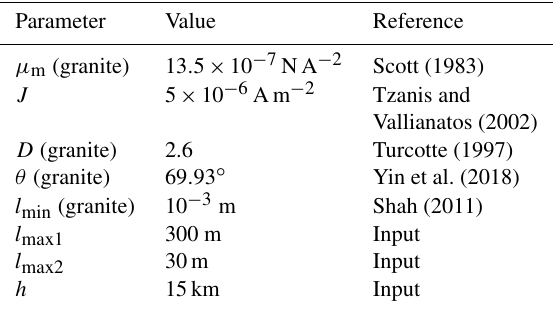
Table 2. Typical values and inputs to Eqs. (3) and